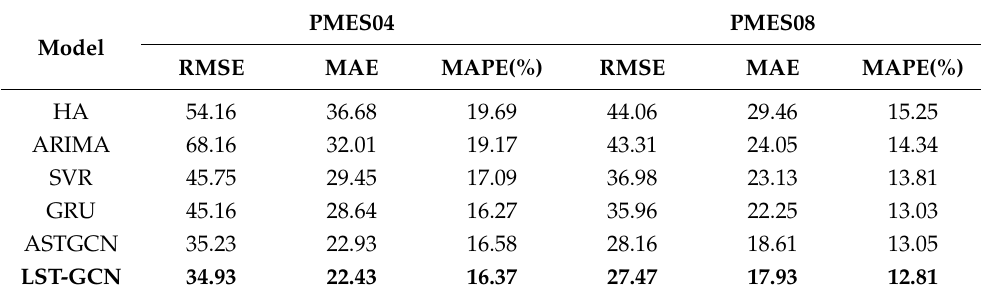
Table 1. Average performance comparison of different approaches on PEMS04 and PEMS08.